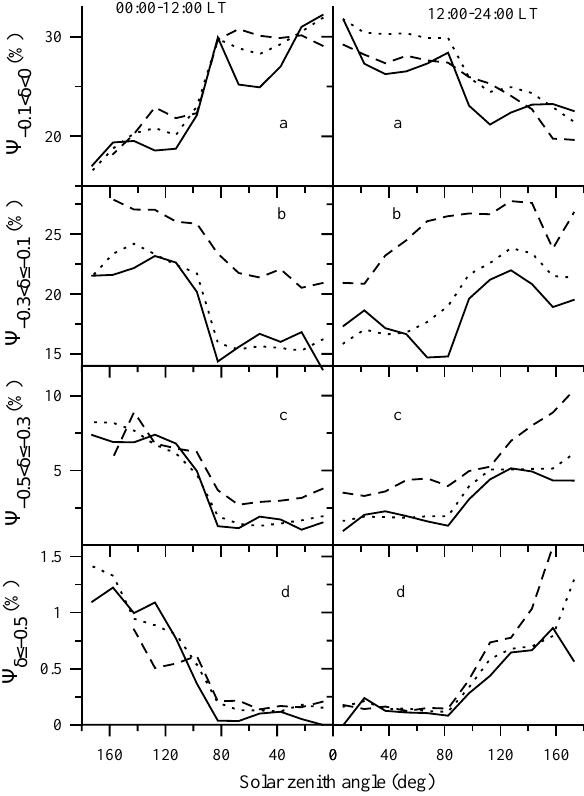
Solar zenith angle (deg) Fig. 7 Fig. 6 Fig. 7. The dependence of the Nm F2 negative disturbance proba- Fig. 6. The dependence of the Nm F2 negative disturbance probabil- bility functions on the solar zenith angle in latitude range 2 (10 ◦ < ity functions on the solar zenith angle in latitude range 1 ( | 8 | ≤ | 8 | ≤ 30 ◦ ) during the winter (solid lines), summer (dashed lines), 10 ◦ ) during the winter (solid lines), summer (dashed lines), and and spring and autumn (dotted lines) months for the weak (panels spring and autumn (dotted lines) months for the weak (panels a), a), normal (panels b), strong (panels c), and very strong (panels normal (panels b), strong (panels c), and very strong (panels d) d) Nm F2 negative disturbances. The 0 ◦ − 180 ◦ solar zenith angle Nm F2 negative disturbances. The 0 ◦ − 180 ◦ solar zenith angle range range includes the local time period from 00:00LT to 12:00LT (left includes the local time period from 00:00LT to 12:00LT (left pan- panels) and from 12:00LT to 24:00LT (right panels). els) and from 12:00LT to 24:00LT (right panels).